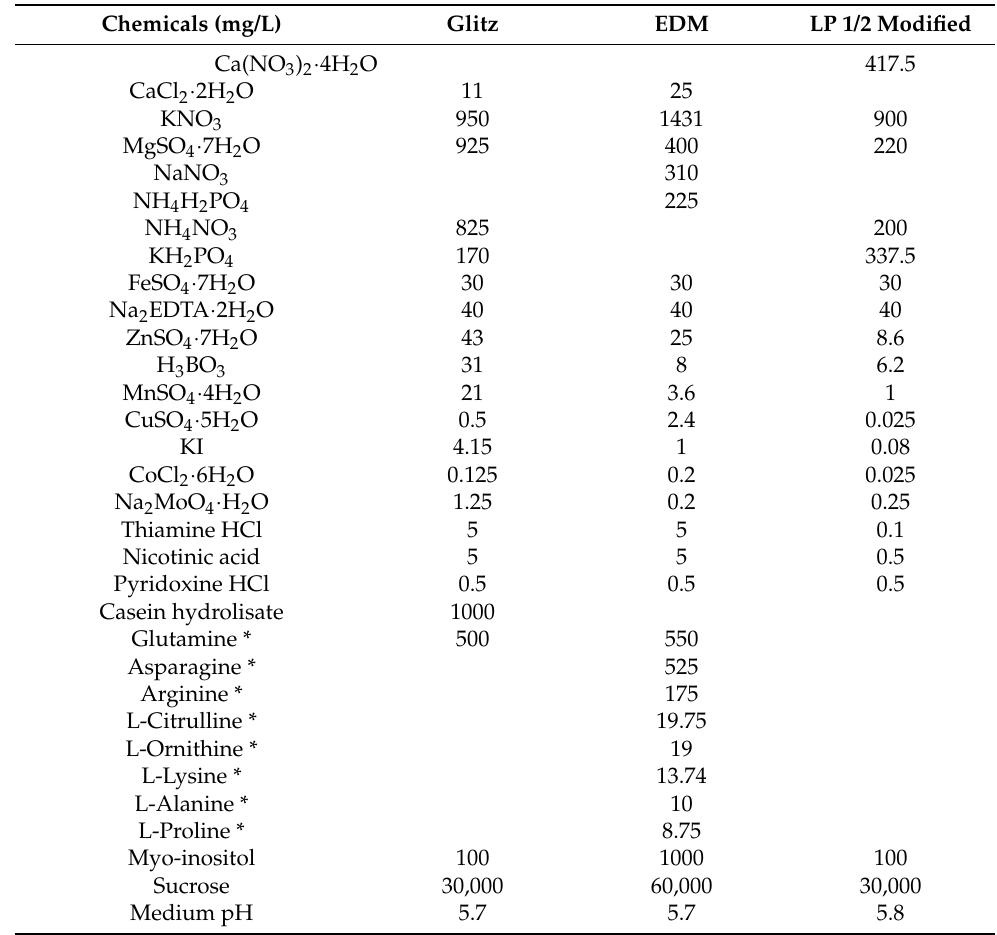
Table 1. Basal media composition for the different media used along the somatic embryogenesis pro- cess in Pinus attenuata × Pinus radiata and the reciprocal hybrid: Glitz medium, embryo development medium (EDM) and half-strength modified Lepoivre medium (LP 1/2